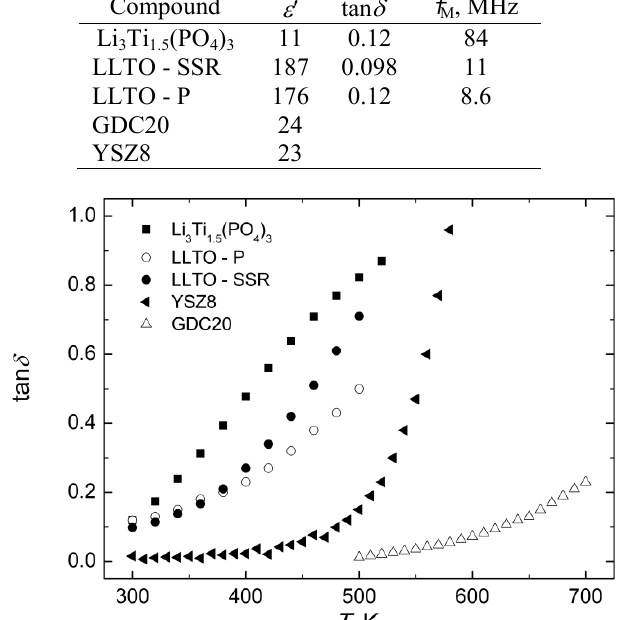
Table 3:  , tan  , f M of ceramic samples measured at 300 K.